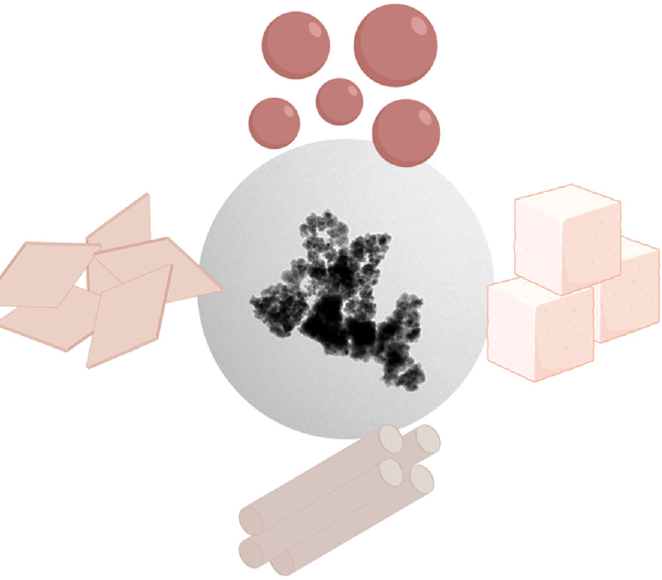
Figure 3. Different shapes can be obtained when synthesizing MNPs, changing their physicochemical properties.